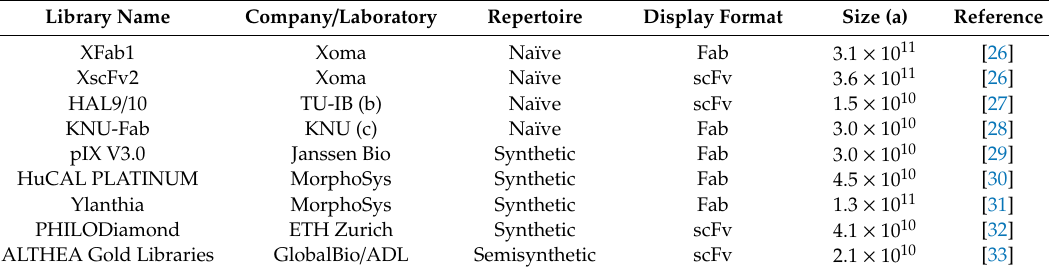
Table 1. Phage display antibody libraries discussed in this